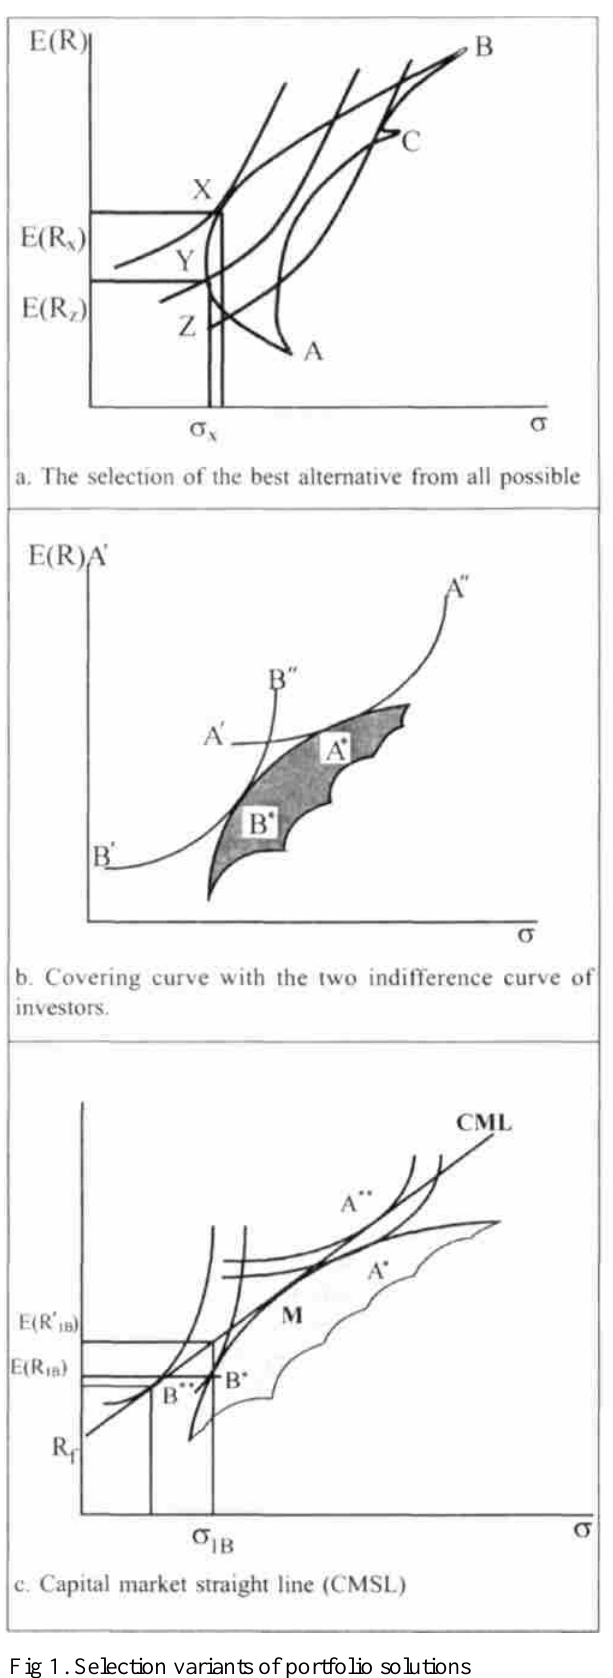
Fig 1. Selection variants of portfolio